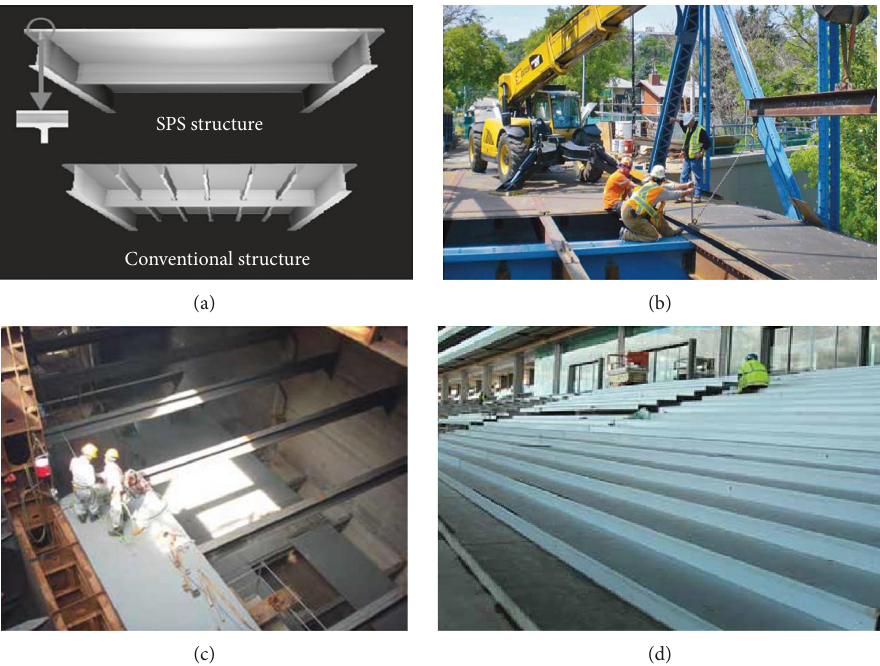
Figure 1: Comparison SPS versus conventional structure: (a) comparison between conventional structure and SPS structure; (b) SPS application as bridge deck; (c) SPS applied as partition board in superstructure of ship; (d) SPS stairs in